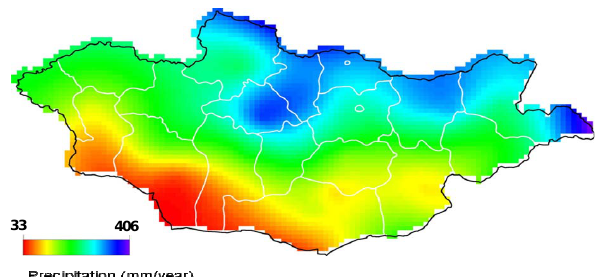
Fig. 2. Raster map of interpolated annual average precipitation in Mongolia derived from the precipitation records of 24 meteorological observatories during 1950–2007 using the minimum curvature method (see text for a more detailed explanation).